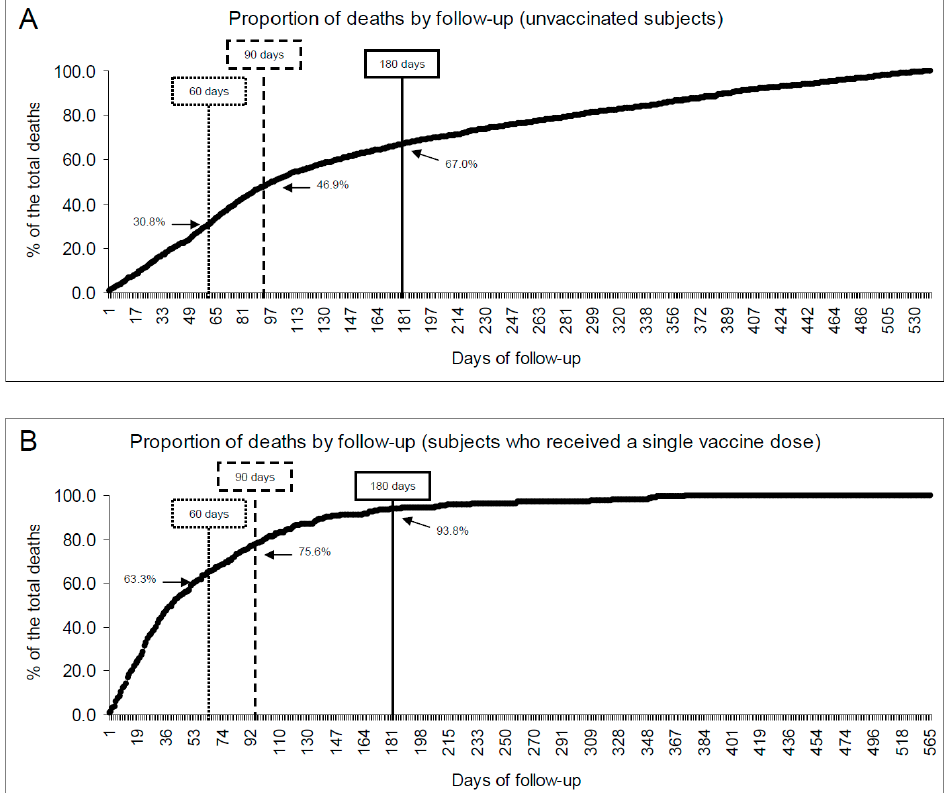
Figure 3. Cumulative proportion of the deaths by follow-up time. Figure 3A ( top ): among unvaccinated subjects; Figure 3B ( bottom ) among partially vaccinated subjects (those who received a single COVID-19 vaccine dose).